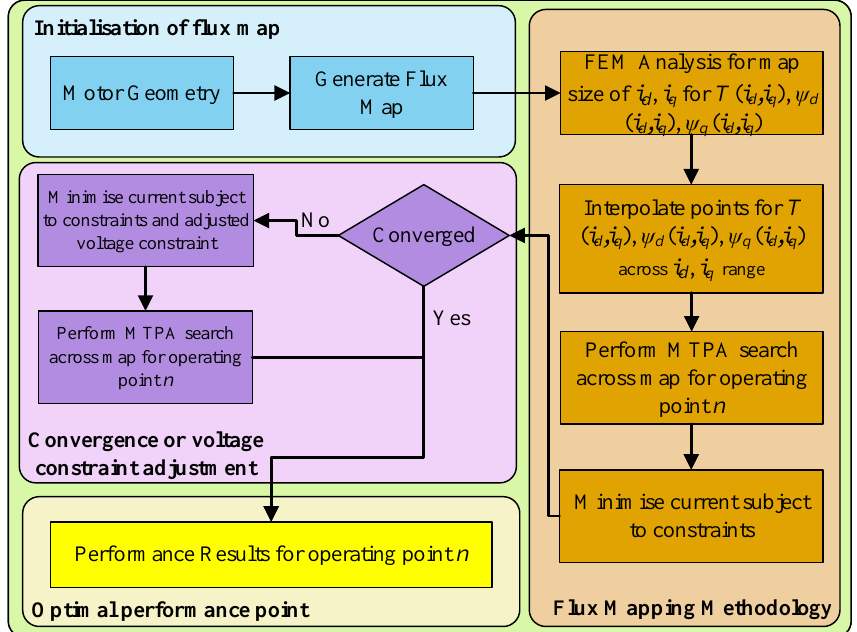
Figure 10. Flux mapping